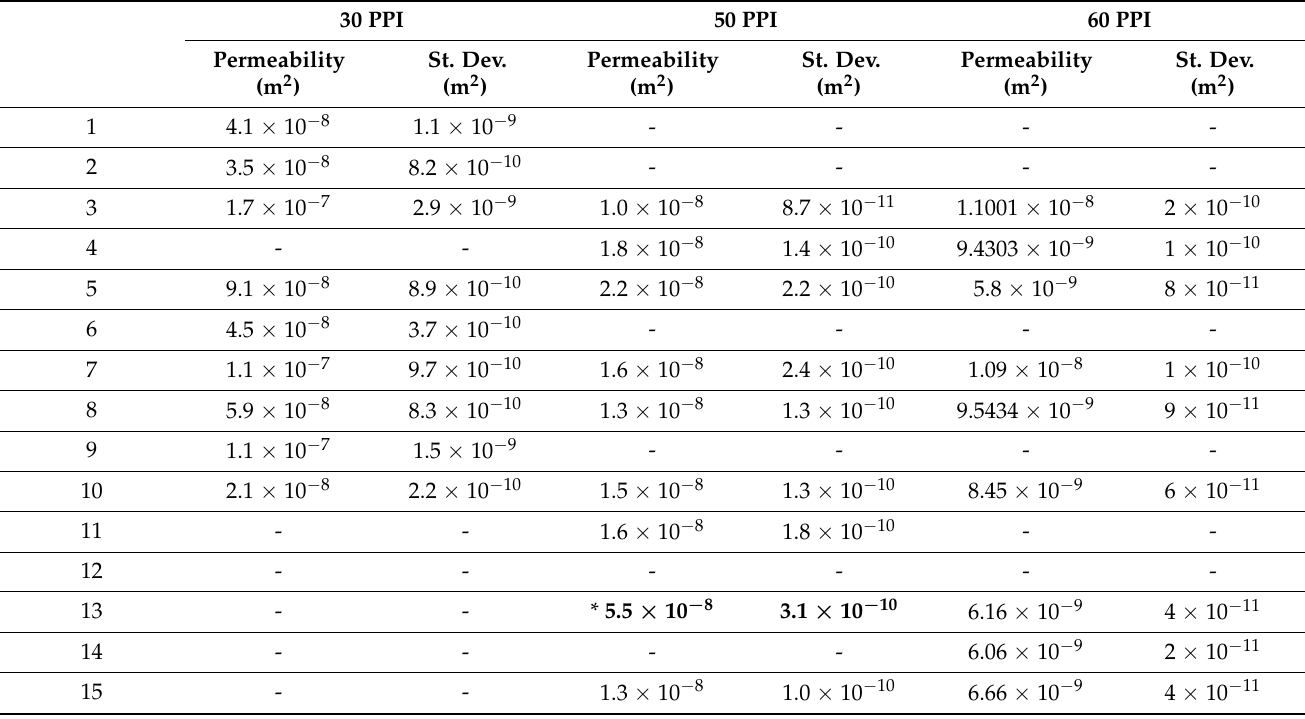
Table A15. Permeability of CFF samples of 30 PPI, 50 PPI and 60 PPI from supplier